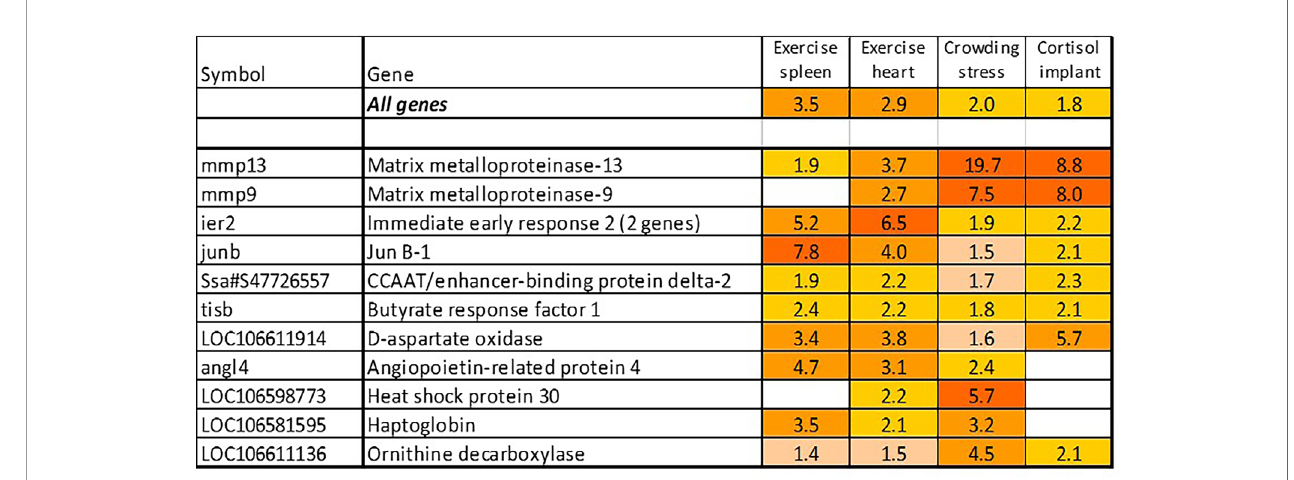
FIGURE 6 | Stress genes. Information on tissues, cells and time-points is in Table 1